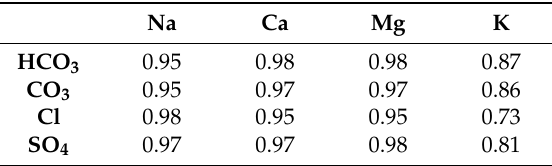
Table 4. Correlation results of cations with